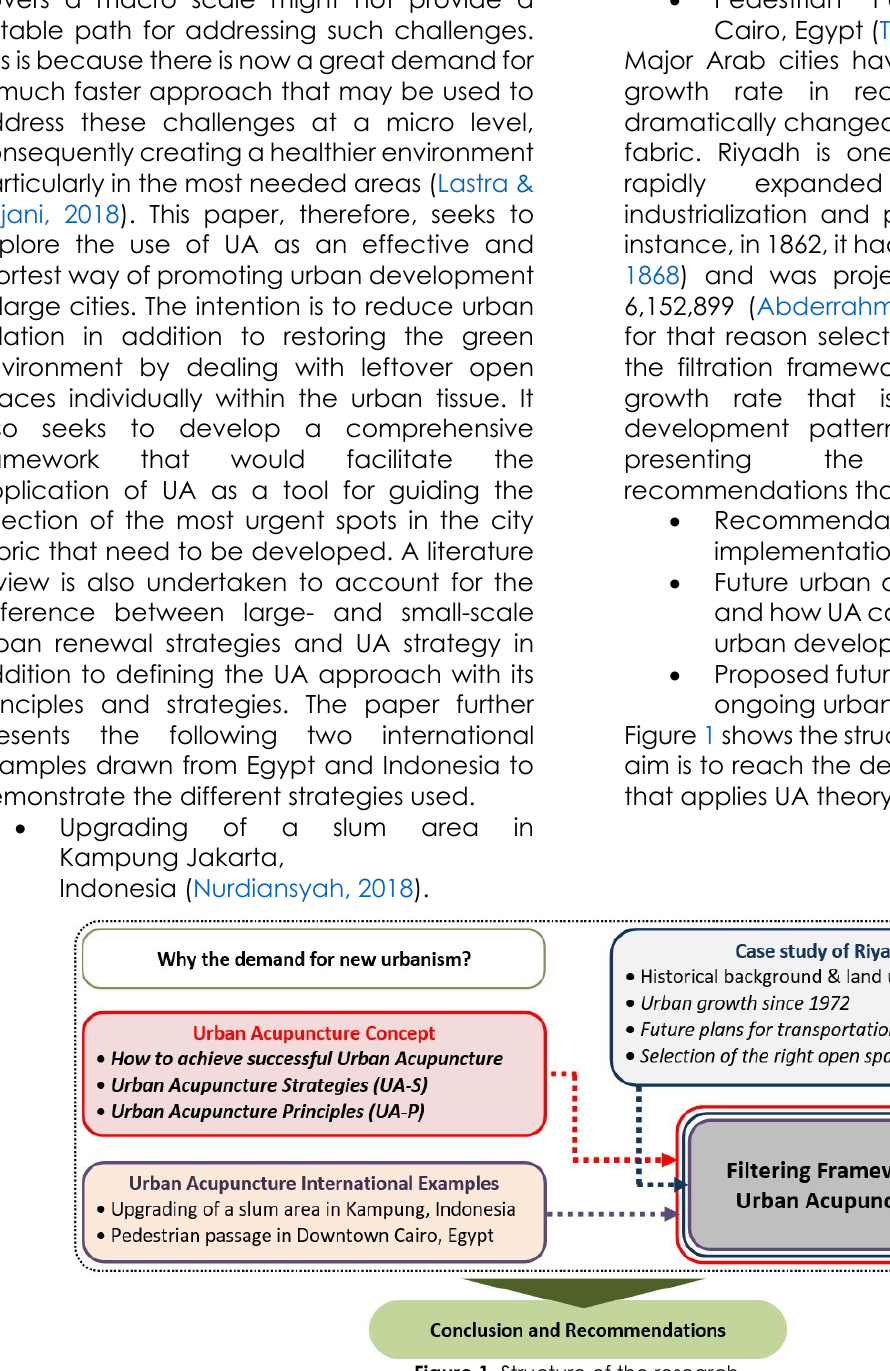
Figure 1. Structure of the